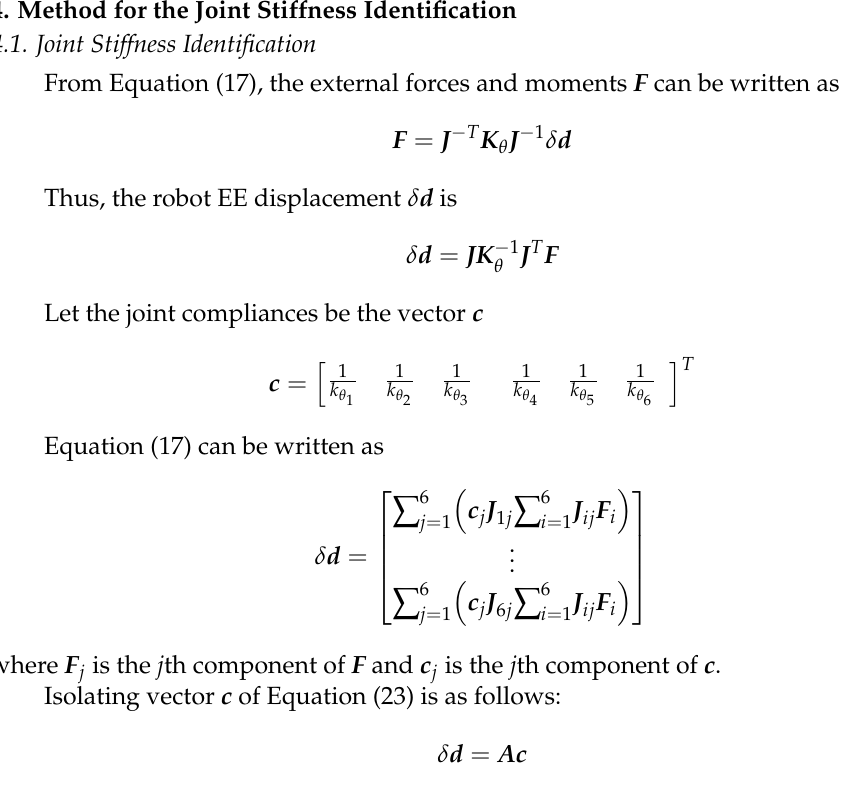
Figure 5. Contour drawing of in the 2 and 3 joint spaces.